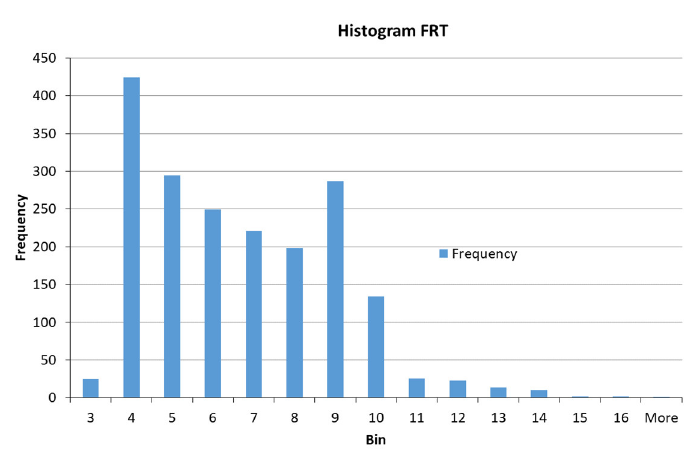
Figure A5. Frother consumption (FRT)—input dataset.